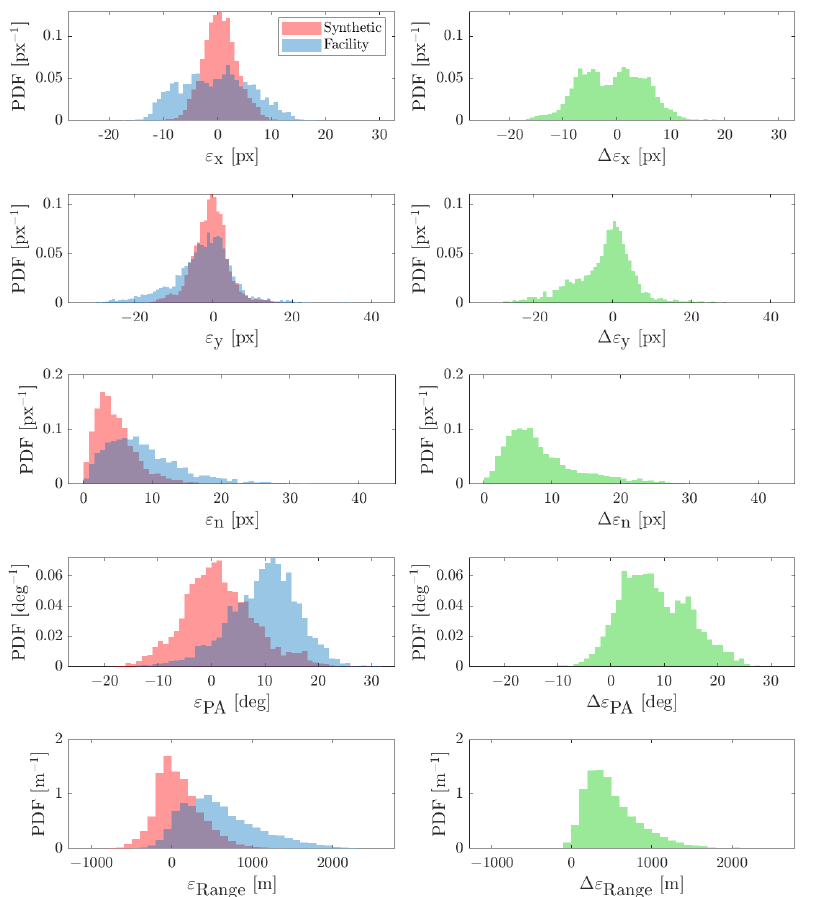
Figure 23. Results for the FRP dataset, shown as PDFs. ( Left ): Estimation error statistics. ( Right ): Difference between the IP output on facility images and the IP output on synthetic images (see Piccolo et al.